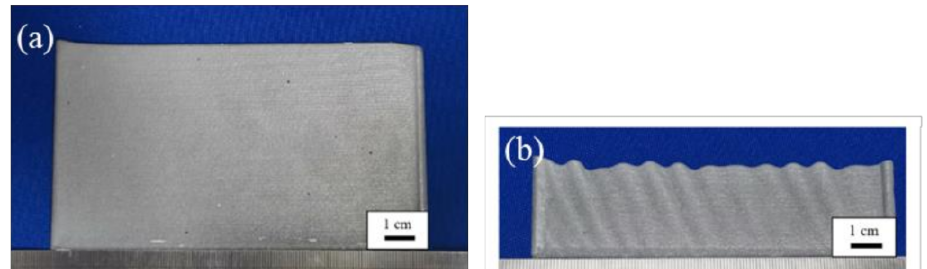
Figure 3. Thin-walled samples deposited by LMD. ( a ) A thin-walled sample deposited during stable process; ( b ) a thin-walled sample deposited during unstable process.